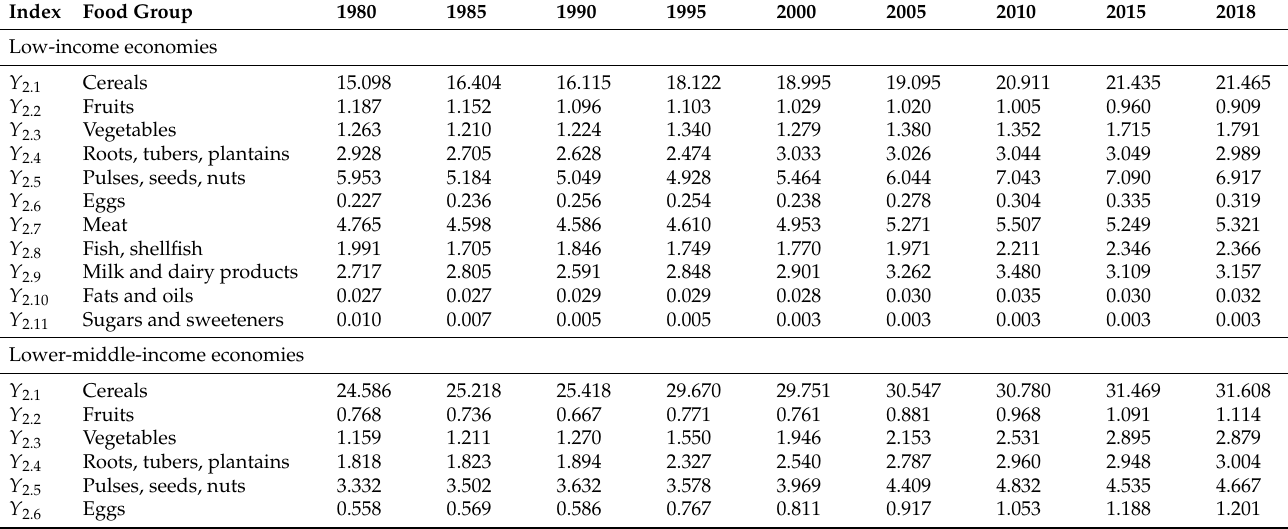
Table A2. Protein supply quantity ( Y 2 ) per country categories and food groups in 1980–2018,